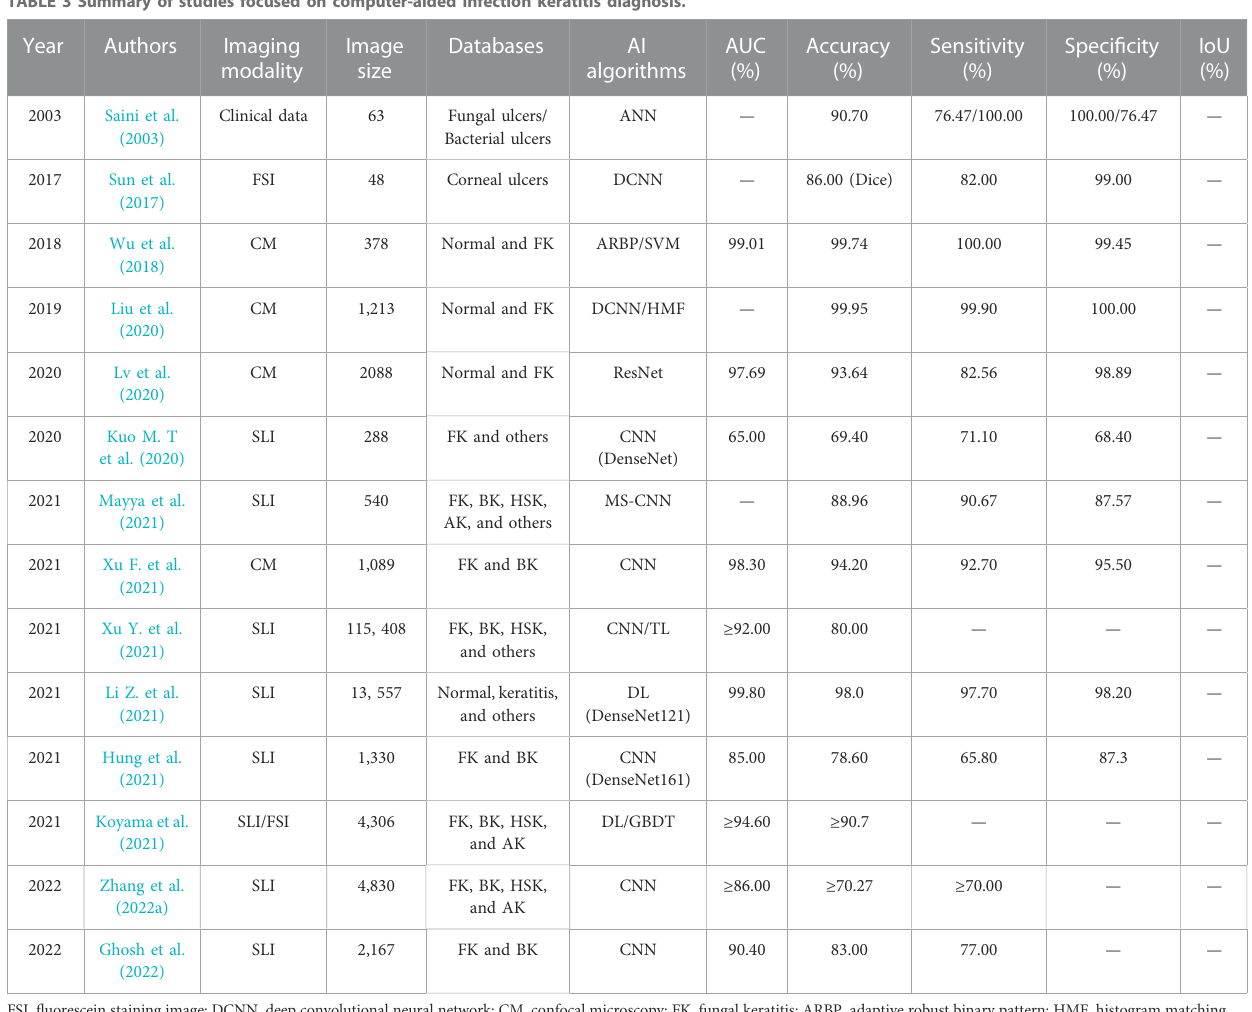
TABLE 3 Summary of studies focused on computer-aided infection keratitis